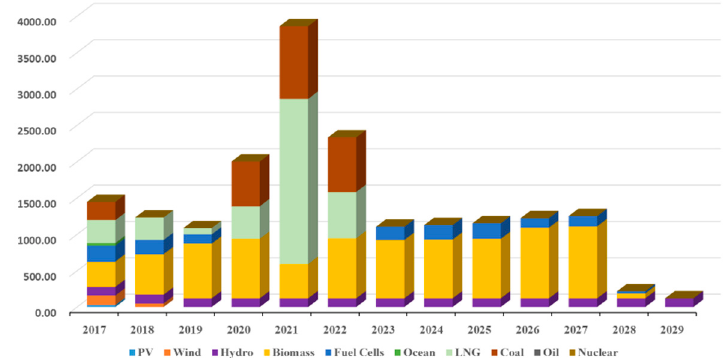
Figure 18. Newly installed capacity of each energy source in SC4. Table 9. Comparison of the ratio of RE/NRE by scenario (SC1 and SC4).